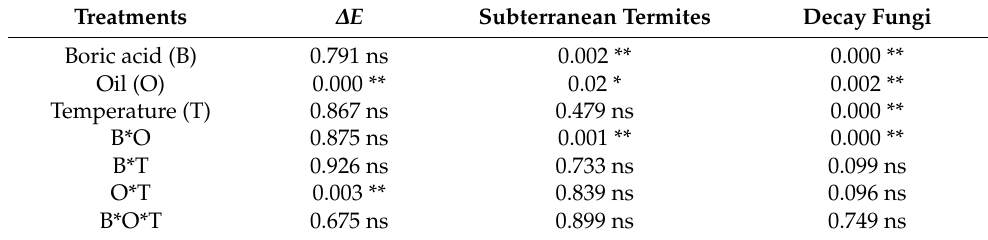
Table 6. Compilation of analyses of variance (ANOVA).